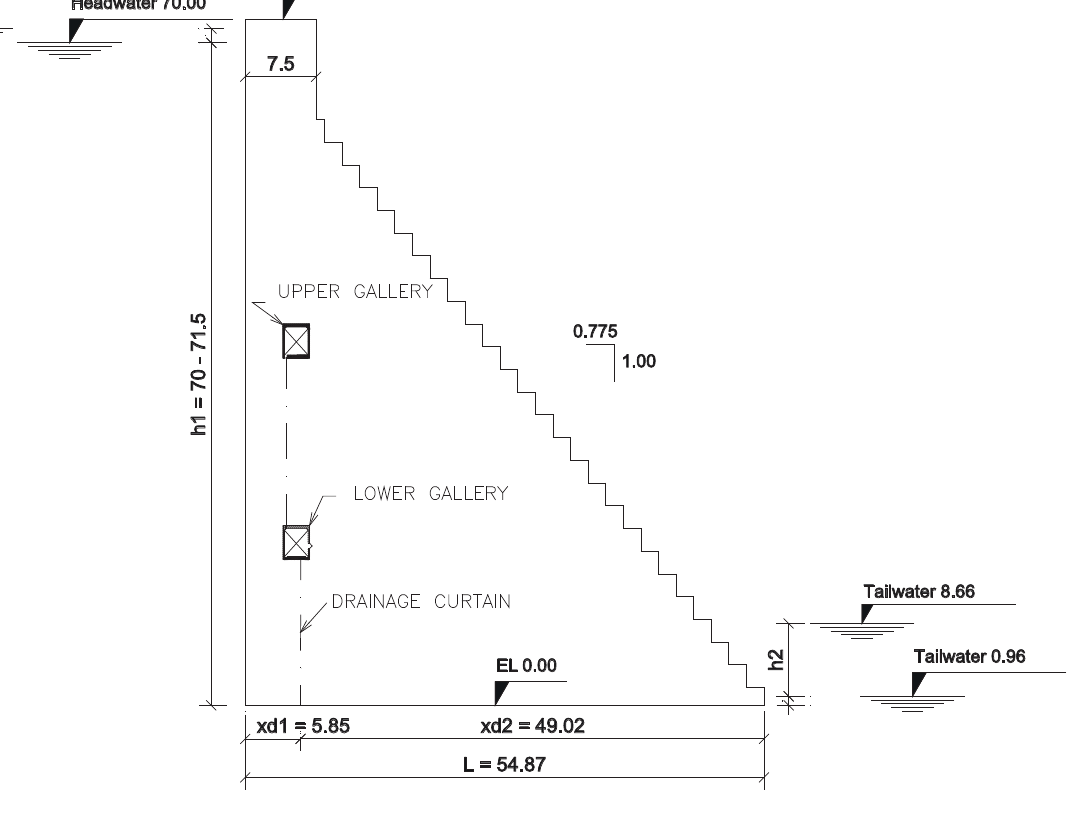
Figure 1 Geometry of the cross section of block n. 30 of the dam